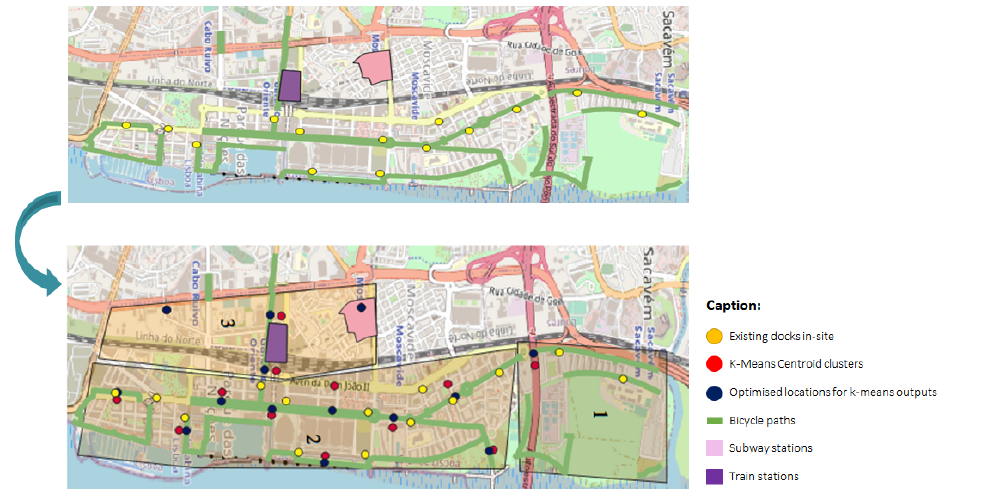
Figure 9. Bike-sharing docking stations in Parque das Nações: Existing docks in-site are represented by yellow dots; red dots represent centroid clusters; dark blue dots represent the optimised locations for K-Means outputs (docking stations over bike paths). Subway has the pink colour polygon, while the purple polygon regards the train station. The map was divided in three segments. Background map source: OpenStreetMap